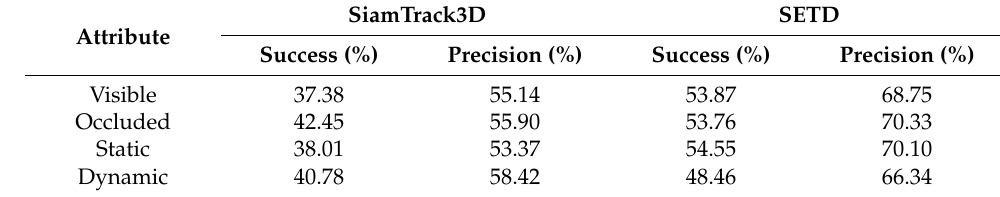
Table 1. Performance comparison with the baseline [2] in terms of several attributes.